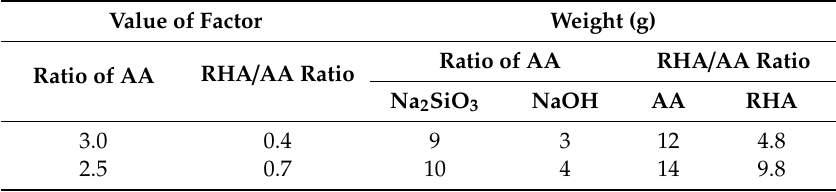
Table 4. Calculated weight ratio for AA and RHA /